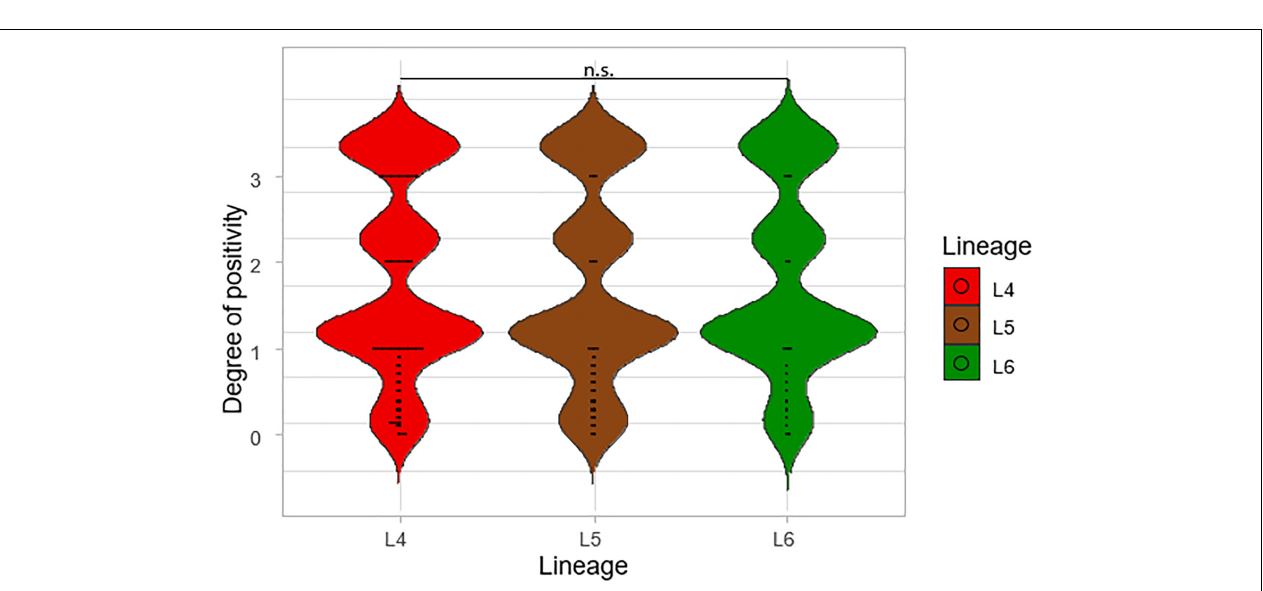
FIGURE 3 | Comparison of smear microscopy results of the lineages. The degree of positivity from the smear microscopy was compared for the three lineages.